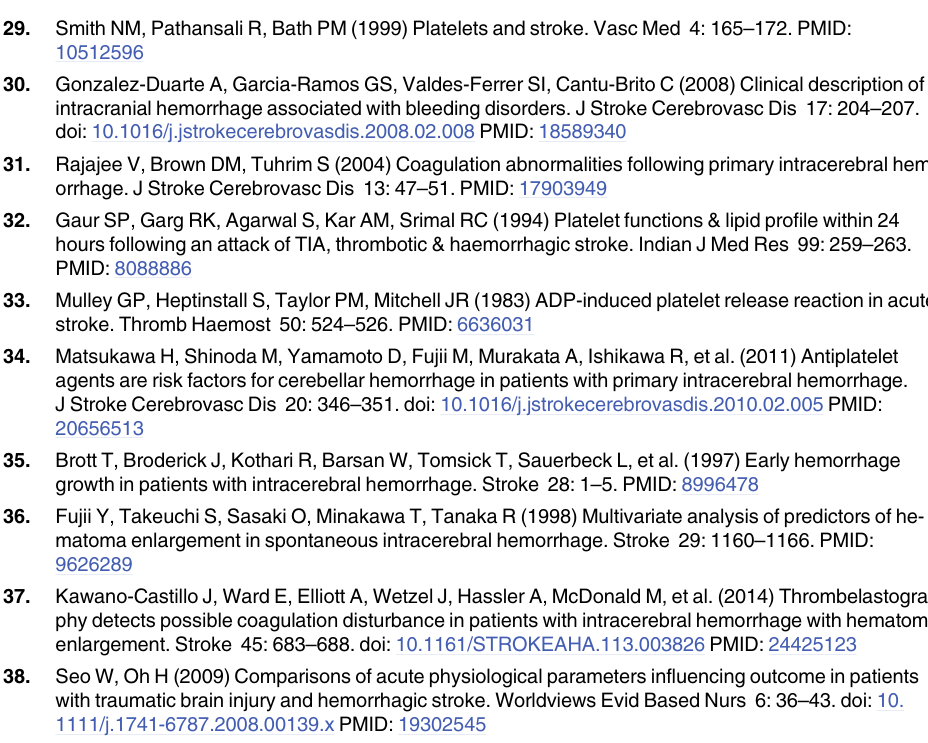
PLOS ONE | DOI:10.1371/journal.pone.0119109 March 17,